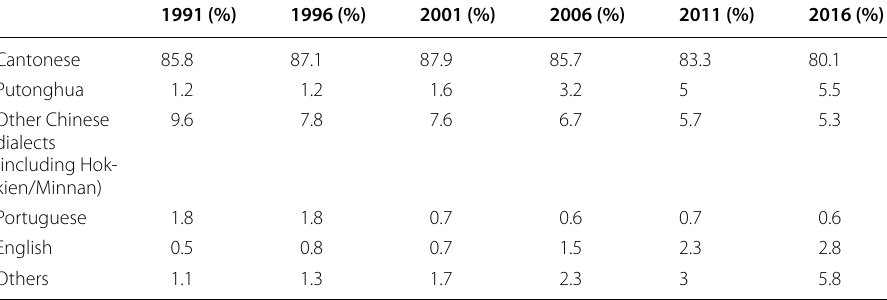
Table 1 Population aged three and above and their primary language choice in Macau (1991– 2016). Source : Adapted from (DSEC, 2002, 2007, 2012,